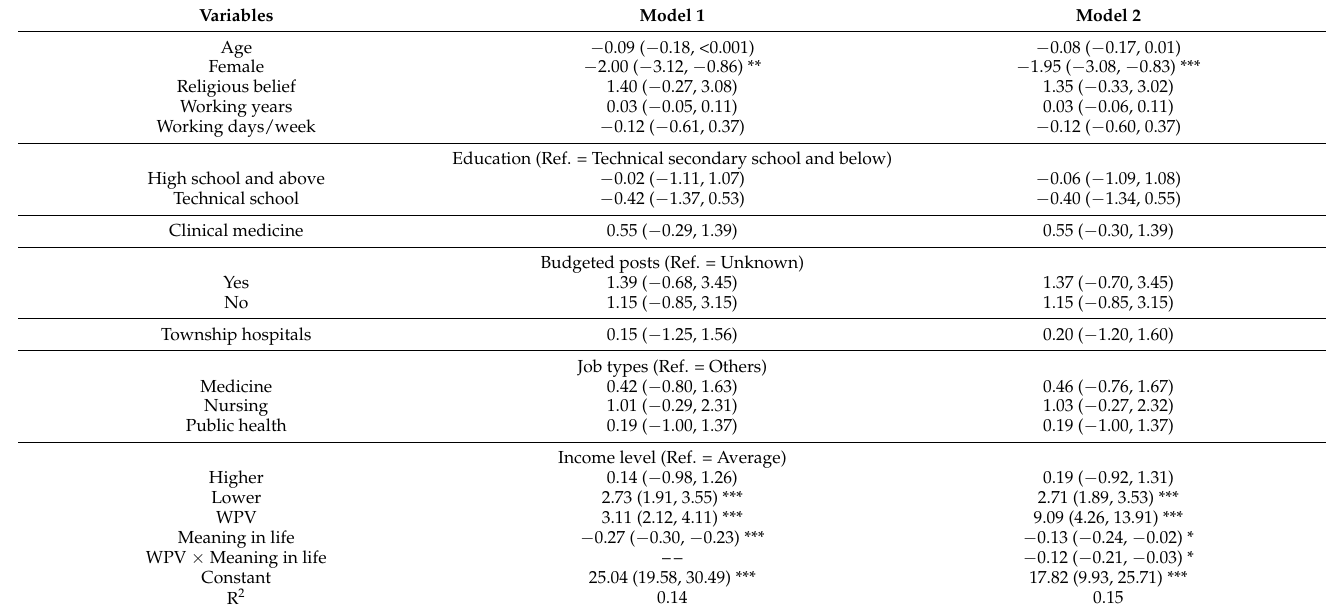
Table 2. Linear regressions for the variables associated with depressive symptoms among primary healthcare professionals [ β (95% CI)].